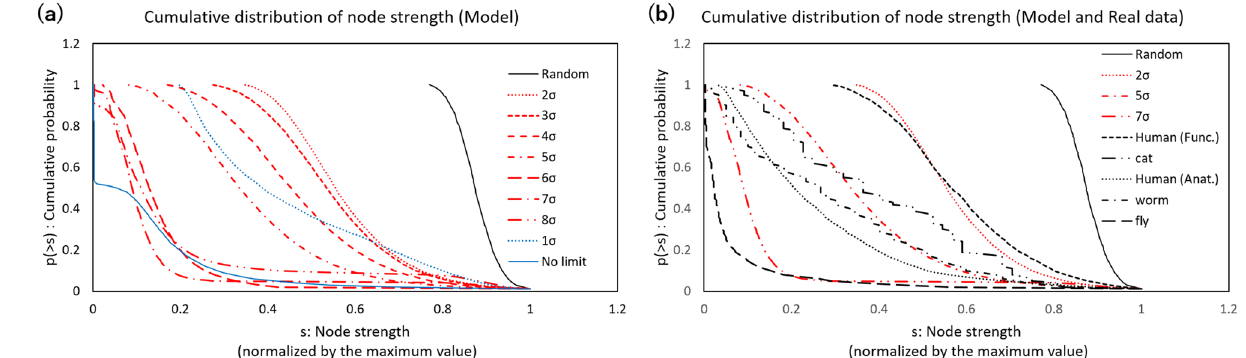
Figure 2. Distribution of node strength. ( a ) Model. The cumulative distribution of node strength, the sum of the connected weights for each node, was plotted. These values were normalized by the maximum value for each network, and then the maximum value on the horizontal axis was fixed at 1. For the model and the random graph, the cumulative distribution was estimated from the results of 100 iterations of the simulation, and each distribution plots 100 points. The upper limit condition for the weight was set at different values form 1 σ to 8 σ as well as the no-limit case; for the activity cost limit, α = 10 − 3 was used. The distributions of the model are shown by red lines except for 1 σ and the no-limit case, which are shown by blue lines. The result of the random graph is shown by the black solid line. ( b ) Model and connectomes. The connectomes of humans 44 and various other animals (the cat 45 , the worm 46 , and the fly 47 ) are overlaid as black dotted and dashed lines, where the distribution of the fly is based on 100 plotted points. The model conditions for 2 σ , 5 σ , and 7 σ were taken from panel ( a